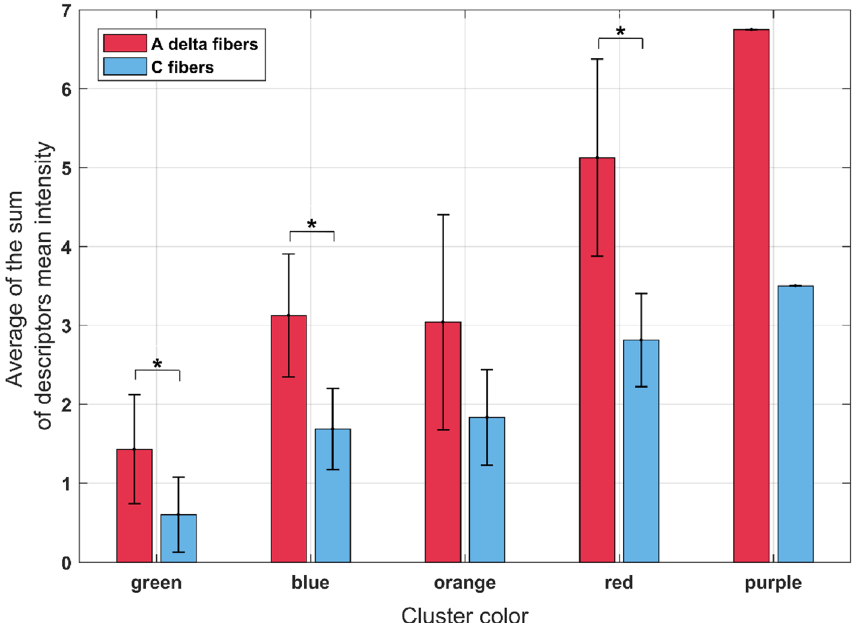
Figure 7. Sum of descriptors mean intensity for three chosen descriptors of both type of nerve fibers: A-delta (red bars) and C-fibers (blue bars). The data is shown as the average value (bar’s height) ± standard error (black vertical bars) for all biphasic pulse protocols included in a particular cluster. The asterisks (*) show statistically significant difference between the nerve fibers in the cluster ( P < 0.05). Note that the purple cluster is only one pulse protocol cluster, thus the standard error is